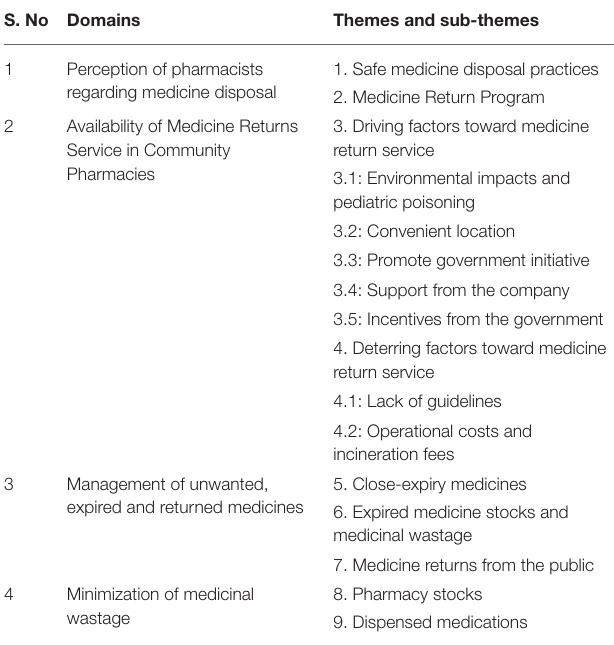
TABLE 2 | Identified domains and themes of the